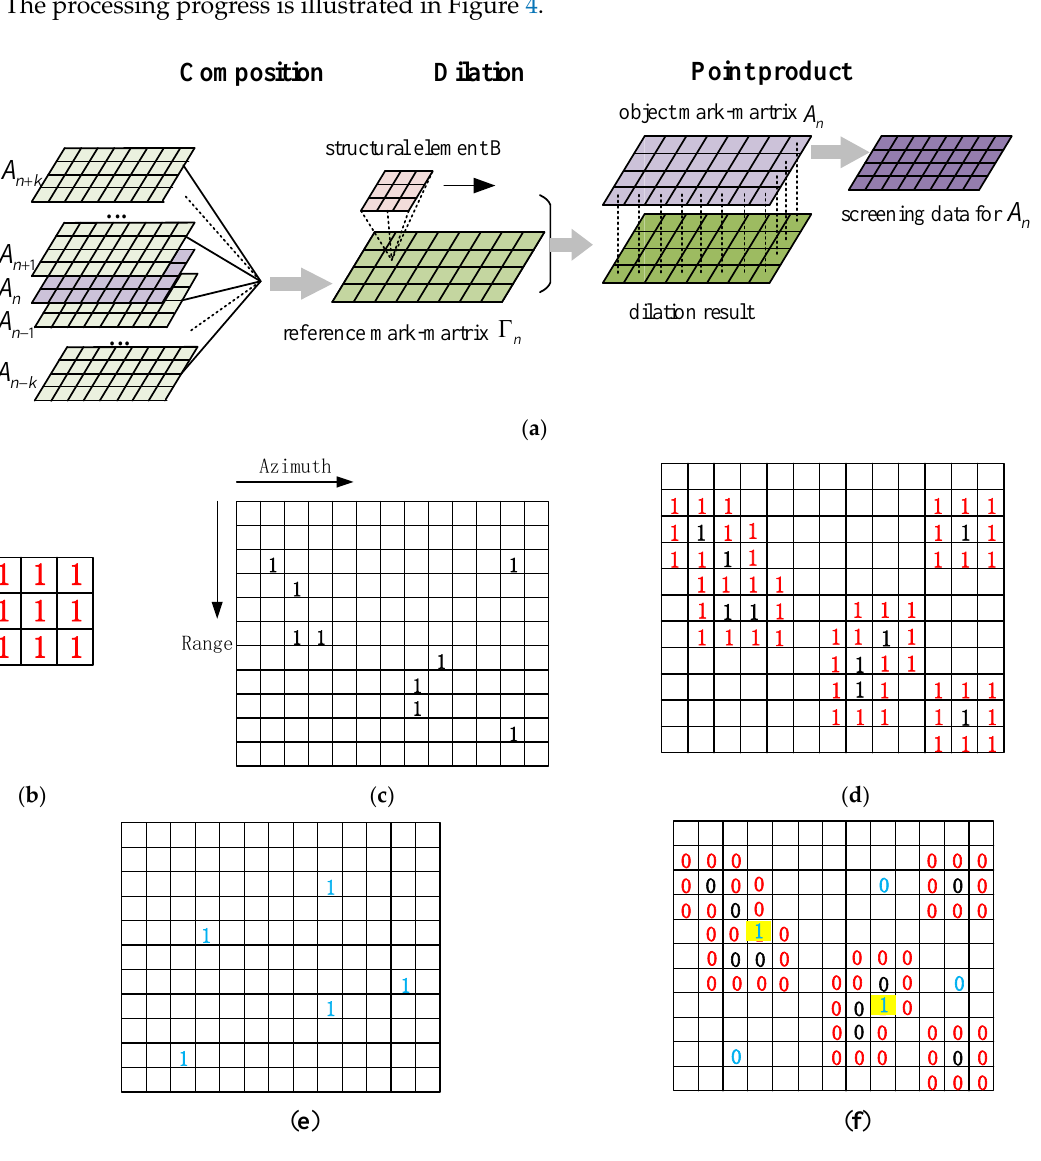
Figure 4. The sketch map of processing progress: ( a ) general view; ( b ) structural element B; ( c ) reference mark-matrix Γ n ; ( d ) dilation result; ( e ) object mark-matrix 𝐴 n ; ( f ) screened data for 𝐴 n .